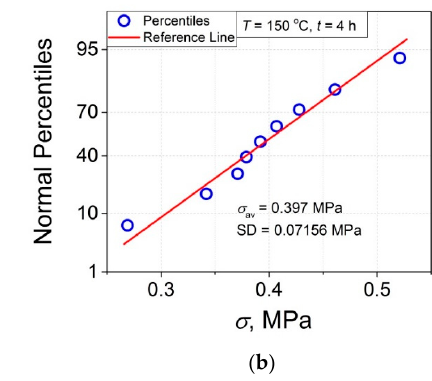
Figure 11. ( a ) Linear regression fit of the lap shear strength σ in Weibull’s coordinates; ( b ) normal probability plot; ( c ) probability density function (PDF) vs. σ fitted with a Gaussian function for an amorphous PET–PET interface self-bonded at T = 150 °C for t = 5 min.